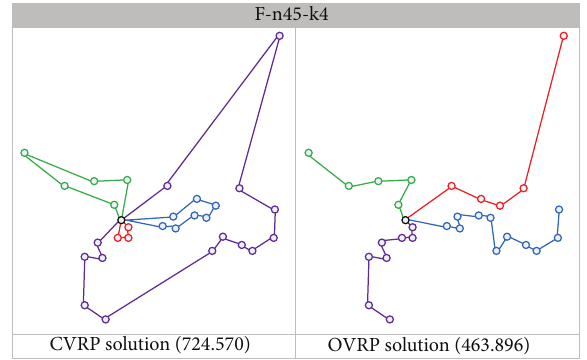
Figure1:ThedifferenceofbestknownsolutionsbetweenCVRPand